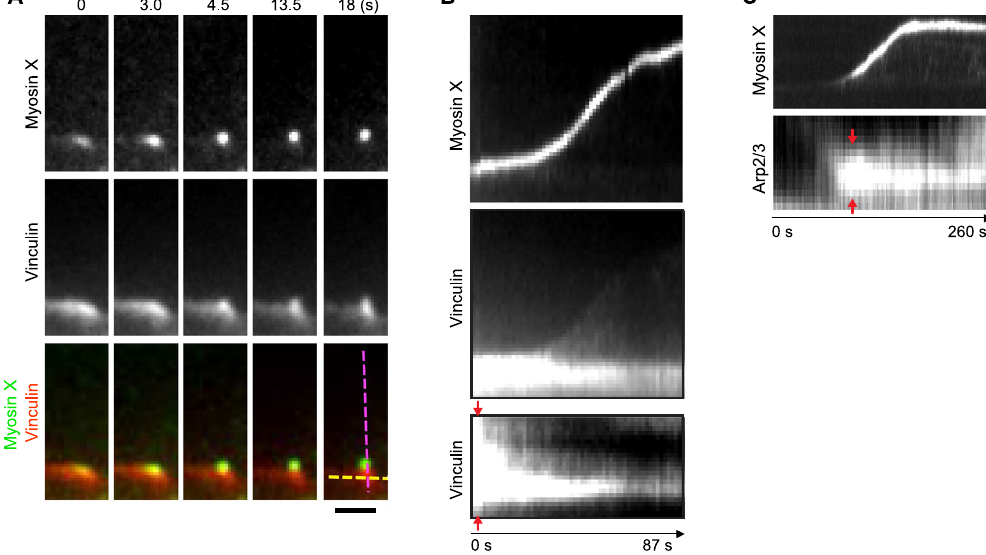
Figure 3. Myosin X converges local-nucleated actin-regulating protein complex during filopodia initiation. ( A ) Time-lapse montages of EGFP-myosin X and vinculin-tomato showed the convergence of local- accumulated vinculin structure during filopodia initiation. ( B ) The corresponding kymographs (top and middle panels) of myosin X and vinculin along filopodial extension (purple dashed line in A ) show the dynamic changes of myosin X and vinculin during filopodia initiation and extension. The bottom kymograph shows the convergence of vinculin at the root of filopodia perpendicular to the direction of filopodia extension (yellow dashed line in A ). ( C ) Kymographs of myosin X along filopodial extension (purple dashed line in Fig. 2C) and Arp2/3 at the root of filopodia perpendicular to the direction of filopodia extension (yellow dashed line in Fig. 2C) are shown for the time-lapse movie shown in Fig. 2C. The red arrows in ( B ) and ( C ) point to the vinculin or Arp2/3 initially localized with significant width along the leading edge of cells from where nascent filopodia extended. Scale bar, 2 μ